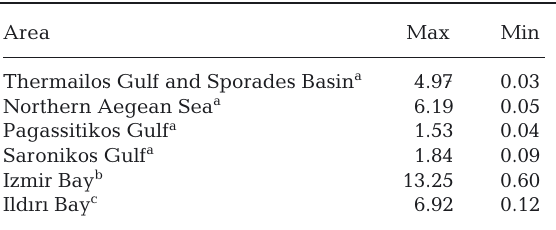
Fig. 9. Seasonal Secchi disk depth:total suspended matter (SDD:TSM) ratios (left axis) and dissolved organic carbon (DOC) distributions (right axis; N. Bizsel unpubl. data) of the entire bay